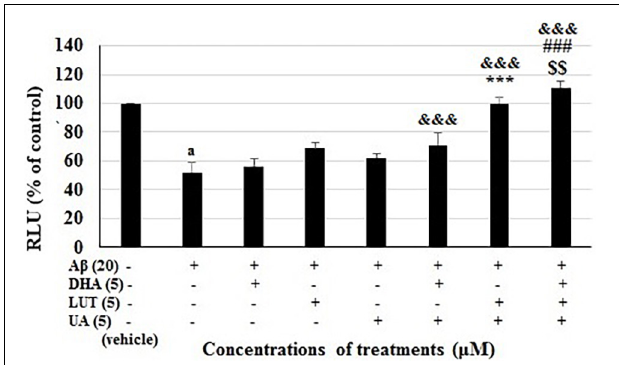
FIGURE 6 | Comparison of the two-compound combinations D 5 U 5 , L 5 U 5 and the three-compound combination D 5 L 5 U 5 . ATP levels for the D 5 U 5 , L 5 U 5 , D 5 L 5 U 5 and their single components were determined using CellTiter Glo assay. Data are expressed as mean ± SD from four ( N = 4) independent experiments. Differences are significant at a P < 0.001 vs. vehicle control, &&& P < 0.001 vs. A β 1 - 42 -treated control, *** P < 0.001, ### P < 0.001 vs. D 5 U 5 and $$ P = 0.001 vs. L 5 U 5 .